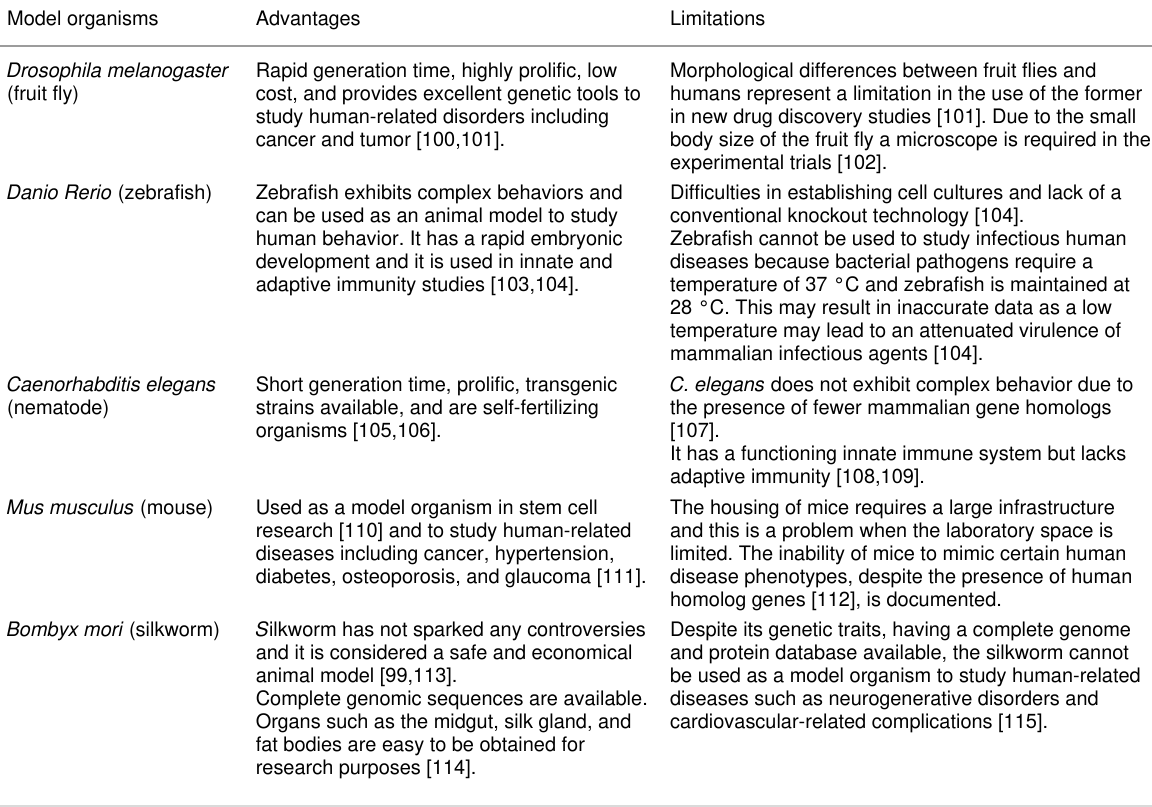
Table 2: The merits and limitations of selected model organisms. Model